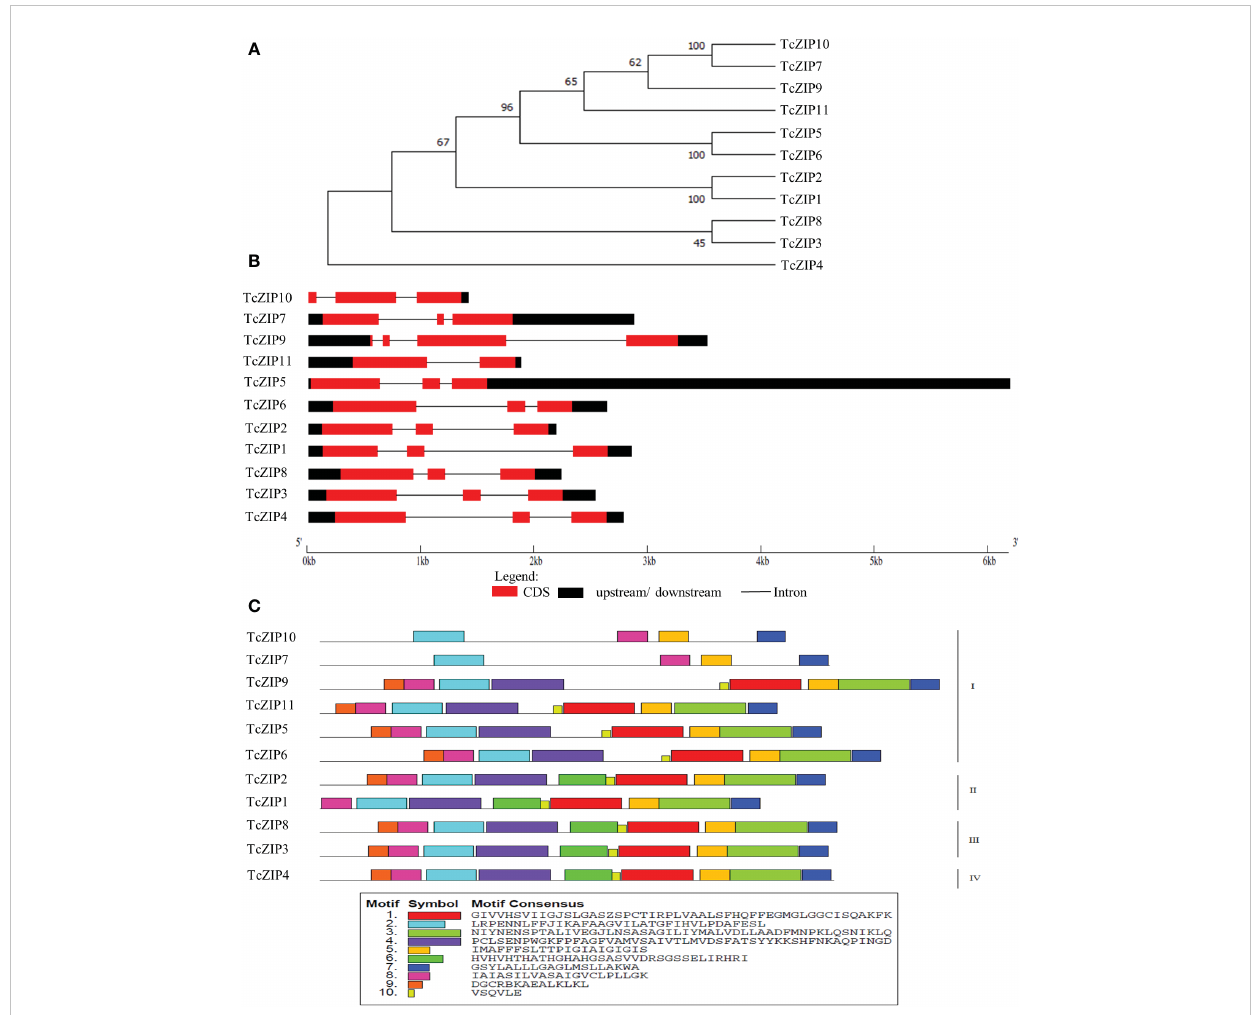
FIGURE 1 The evolutionary relationships, gene structures and functional motifs of transport proteins in T. cacao (TcZIP). (A) A phylogenetic tree constructed using MEGA11 software by the NJ method with bootstrap analysis (1000 replicates). (B) Gene structures, CDS, upstream/downstream, and introns are shown. (C) Composition of each TcZIP proteins motif. Motifs 1-10 are displayed as differently colored boxes with corresponding sequence information for each